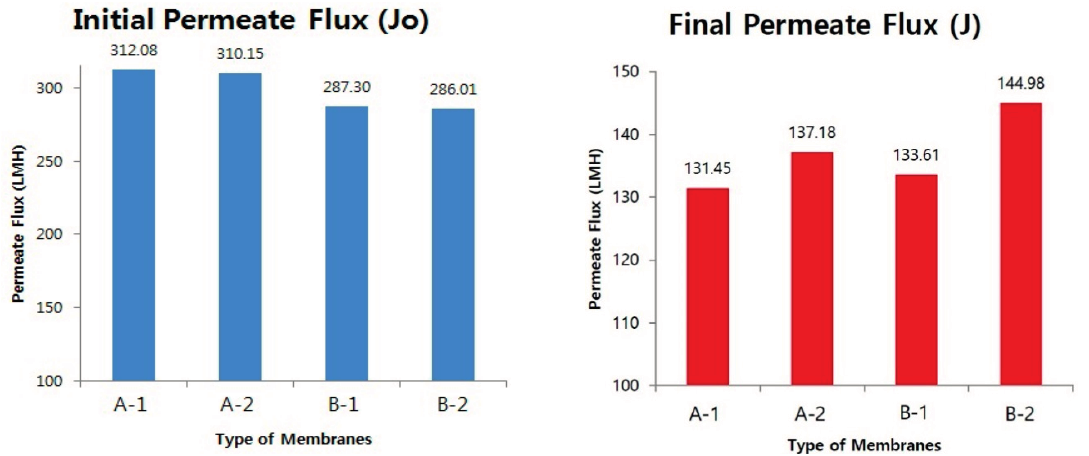
Figure 8. Permeate flux of membranes during filtration of 6 ppm HA solution at 1